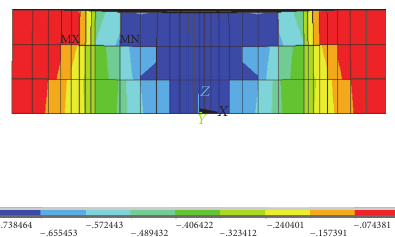
Figure 6: Vertical stress cloud of central section.